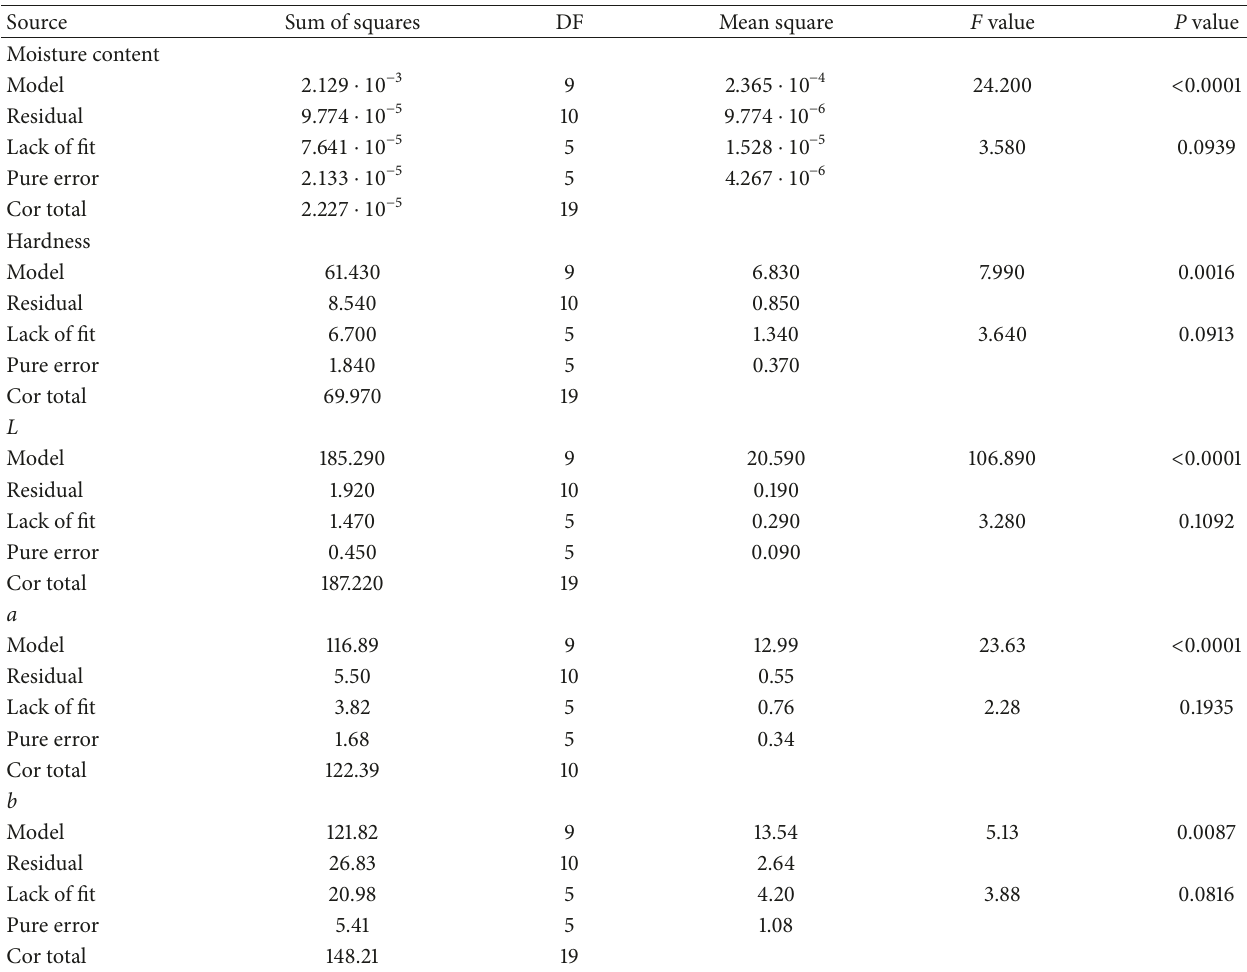
Table 4: The results of analysis of variance (ANOVA) of the fitted second-order polynomial models for the moisture content, hardness, and color of the restructured